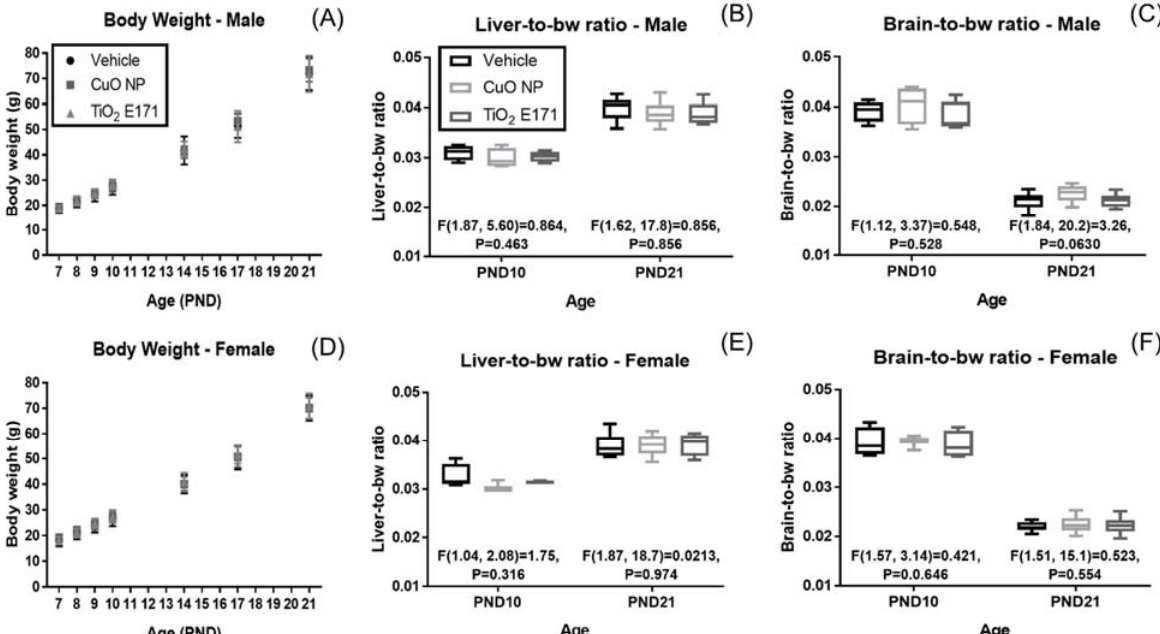
Figure 1. Body weight (bw), liver-to-bw ratio, and brain-to-bw ratio for male ( A – C ) and female ( D – F ) rat pups dosed between PND 7–10. No changes were observed in body weight as a result of NP oral dosing. While NP administration did not cause in organ-to-bw ratio changes, a clear difference was observed between ages PND 10 and PND 21. Body weight is presented as mean ± standard deviation. Box and whisker plots of organ-to-bw ratio data with statistical F values are shown.